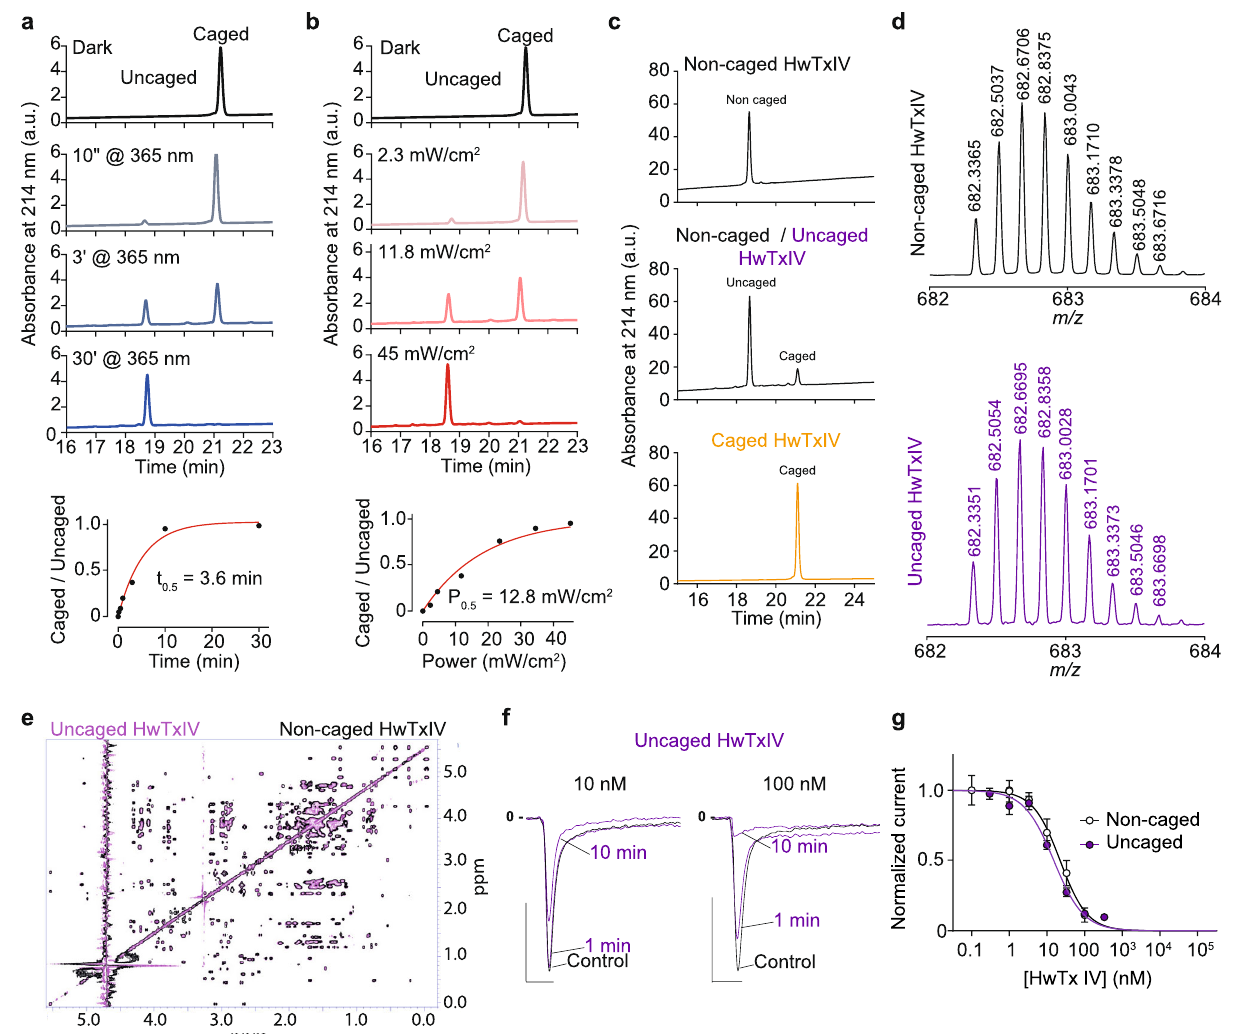
Fig. 3 Physico-chemical and electrophysiogical properties of HwTxIV-Nvoc. a Top: Analytical RP-HPLC pro fi les of HwTxIV-Nvoc after different durations of illuminations (365 nm, 45mW/cm 2 ) demonstrating time-dependent control of uncaging. Bottom: Uncaged/Caged ratio of HPLC chromatogram peaks area versus irradiation time at 365 nm (45 mW/cm 2 ). b Top: Analytical RP-HPLC pro fi les of HwTxIV-Nvoc after different intensities of illuminations (365 nm, 5 min) demonstrating intensity-dependent control of uncaging. Bottom: Uncaged/Caged ratio of HPLC chromatogram peaks area versus irradiation power at 365 nm (3 min). c Analytical RP-HPLC pro fi les of non-caged HwTxIV (top), 50:50 ratio of noncaged HwTxIV after partial uncaging of HwTxIV-Nvoc (middle) and of HwTxIV-Nvoc (bottom). d Mass analyses of noncaged HwTxIV and uncaged HwTxIV by LC-ESI QTOF ([M + 6H] 6 + values). e Superimposition of TOCSY spectra (same area as Fig. 1e) of the noncaged HwTxIV (in black), and of the uncaged HwTxIV after illumination of HwTxIV-Nvoc (in purple). f Representative recording of hNa V 1.6 currents elicited at 10 mV from a holding potential of -100 mV illustrating the extent of current block by different concentrations of non-caged HwTxIV (black) and uncaged HwTxIV (purple). Scales: 2 ms, 1 nA. g Average dose-response curves for hNa v 1.6 current inhibitions by non-caged HwTxIV (black) and uncaged HwTxIV (purple). The data were fi tted according to a Hill equation (noncaged HwTxIV IC 50 = 22.4 nM ( n = 5) and uncaged HwTxIV IC 50 = 15.20 nM ( n = 6)). Data are presented as mean ± SEM. Source data are provided as a Source Data Spatiotemporal control of HwTxIV activity in brain slices . To expand our approach to biological systems, we assessed the use of HwTxIV-Nvoc in mouse brain slices during optical measure- ments of Na + in fl ux. We fi rst determined that action potentials (APs) recorded in neocortical layer-5 (L5) pyramidal neurons were inhibited by local application of 500 nM noncaged HwTxIV from the surface of the brain slice near the cell body (Fig. 5a).